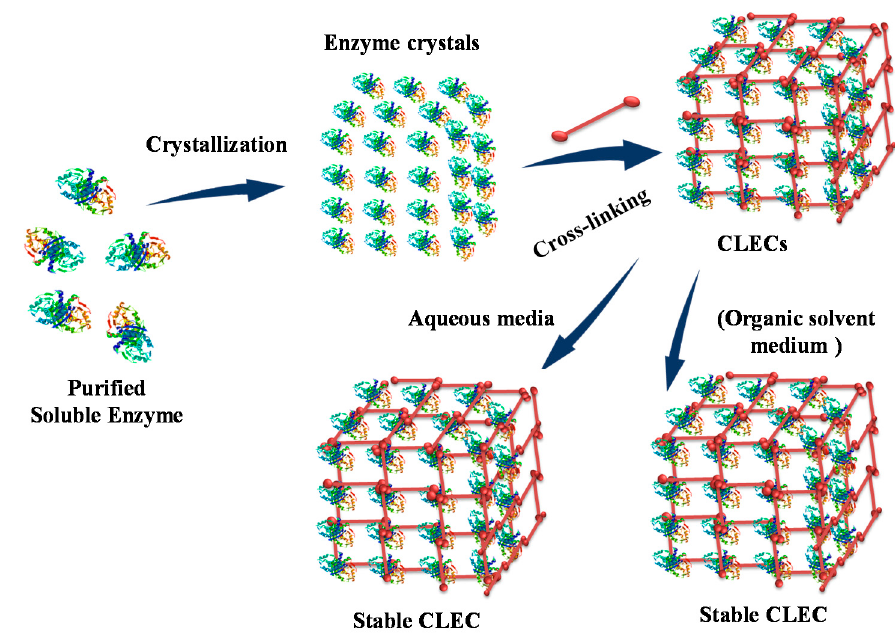
Figure 2. Schematic representation of the enzyme immobilization via cross-linked enzyme crystals (CLECs).